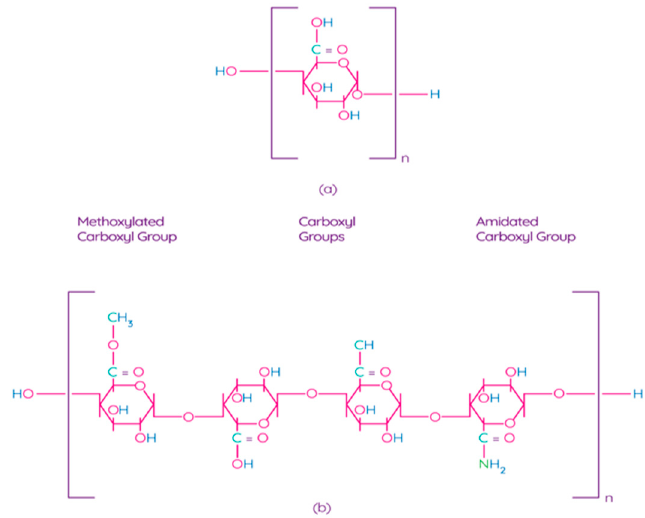
Figure 4. Chemical structure of polygalacturonic acid ( a ) and representative chemical structure of pectin, showing typical repeating groups ( b ) [72]. Reproduced with permission from Espitia, P.J.P. et al., Food Hydrocolloids; published by Elsevier Ltd., 2013.